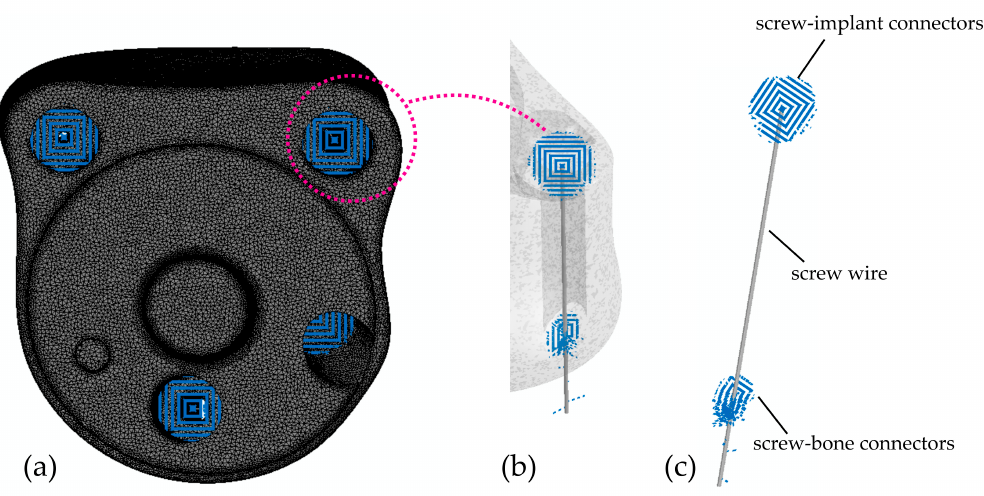
Figure 3. Left ( a ), top view of the model and the four screws. In blue the connectors between screw head and implant. Right ( b ), detail of one screw (implant transparent). Right ( c ), the generated screw